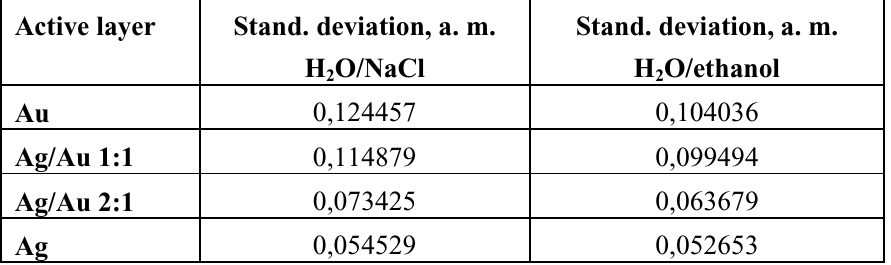
Table 2. Standard deviation of the resonance angle measured on different resonance phases: an application as a refractometer. Active layer Stand. deviation, a. m. Stand. deviation, a. m.